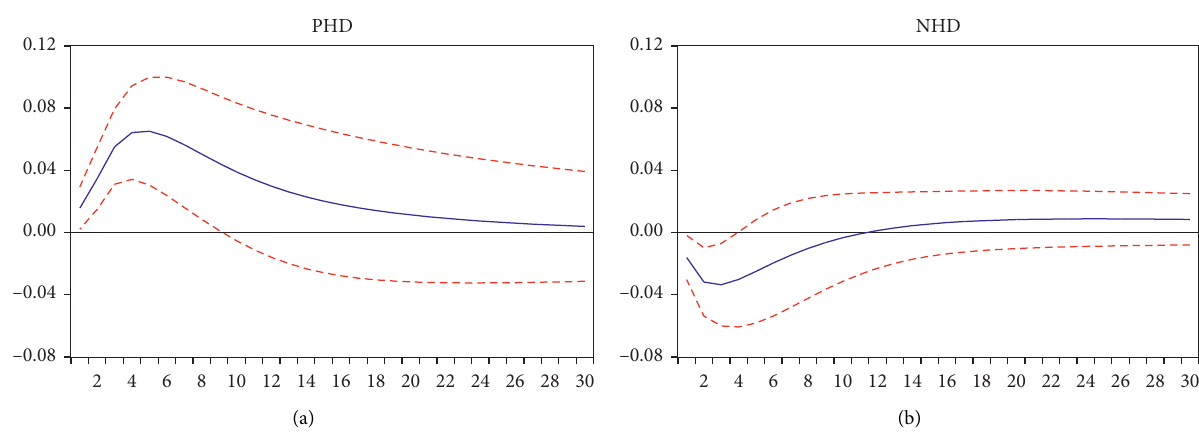
Figure 12: Responses of WTI oil prices to different shocks. (a) Response of WTI oil prices to a PHD shock. (b) Response of WTI oil prices to a NHD shock.